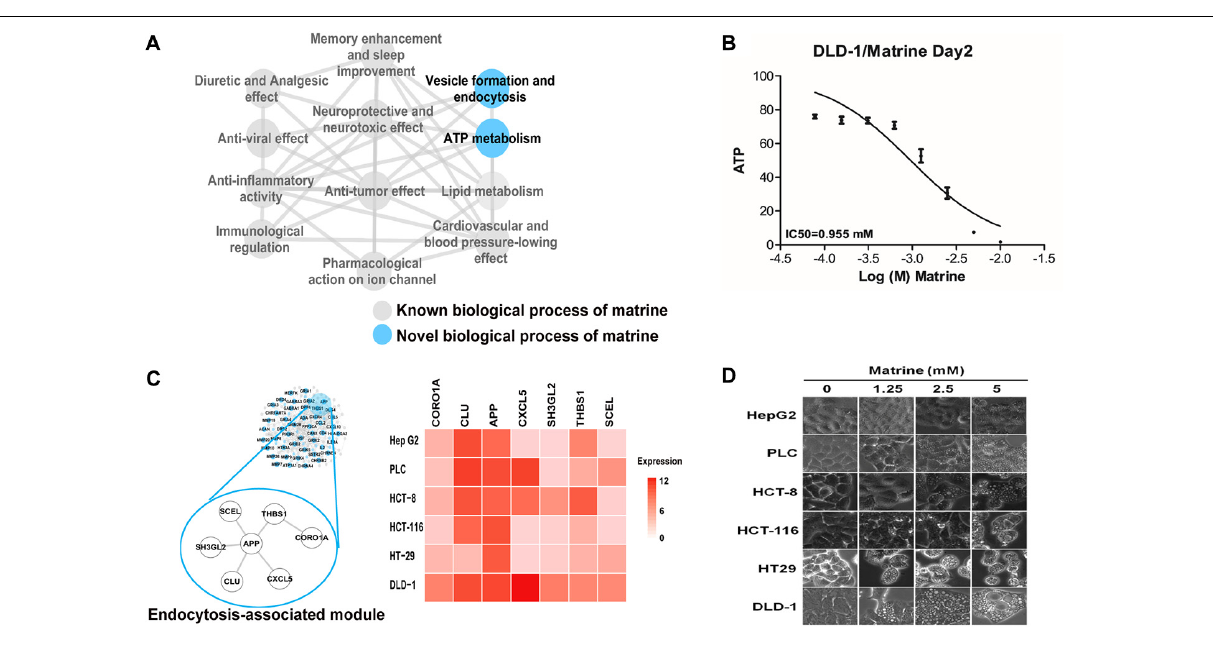
FIGURE 3 | Identification and preliminary validation of novel functions of matrine. (A) Biological process network represents the comprehensive functional characterization of matrine using our network pharmacology approach. Blue nodes represent unreported biological processes of matrine. (B) Dose-effect relationship of matrine on cellular ATP level. (C) The endocytosis-associated network module of matrine with expression in different cancer cell lines. (D) Cell phenotype changing after different cancer cells treated with matrine (1.25–5 µ